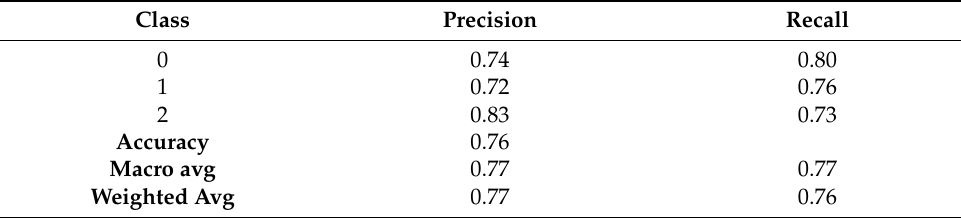
Table 5. Classification report of Random Forest classifier.